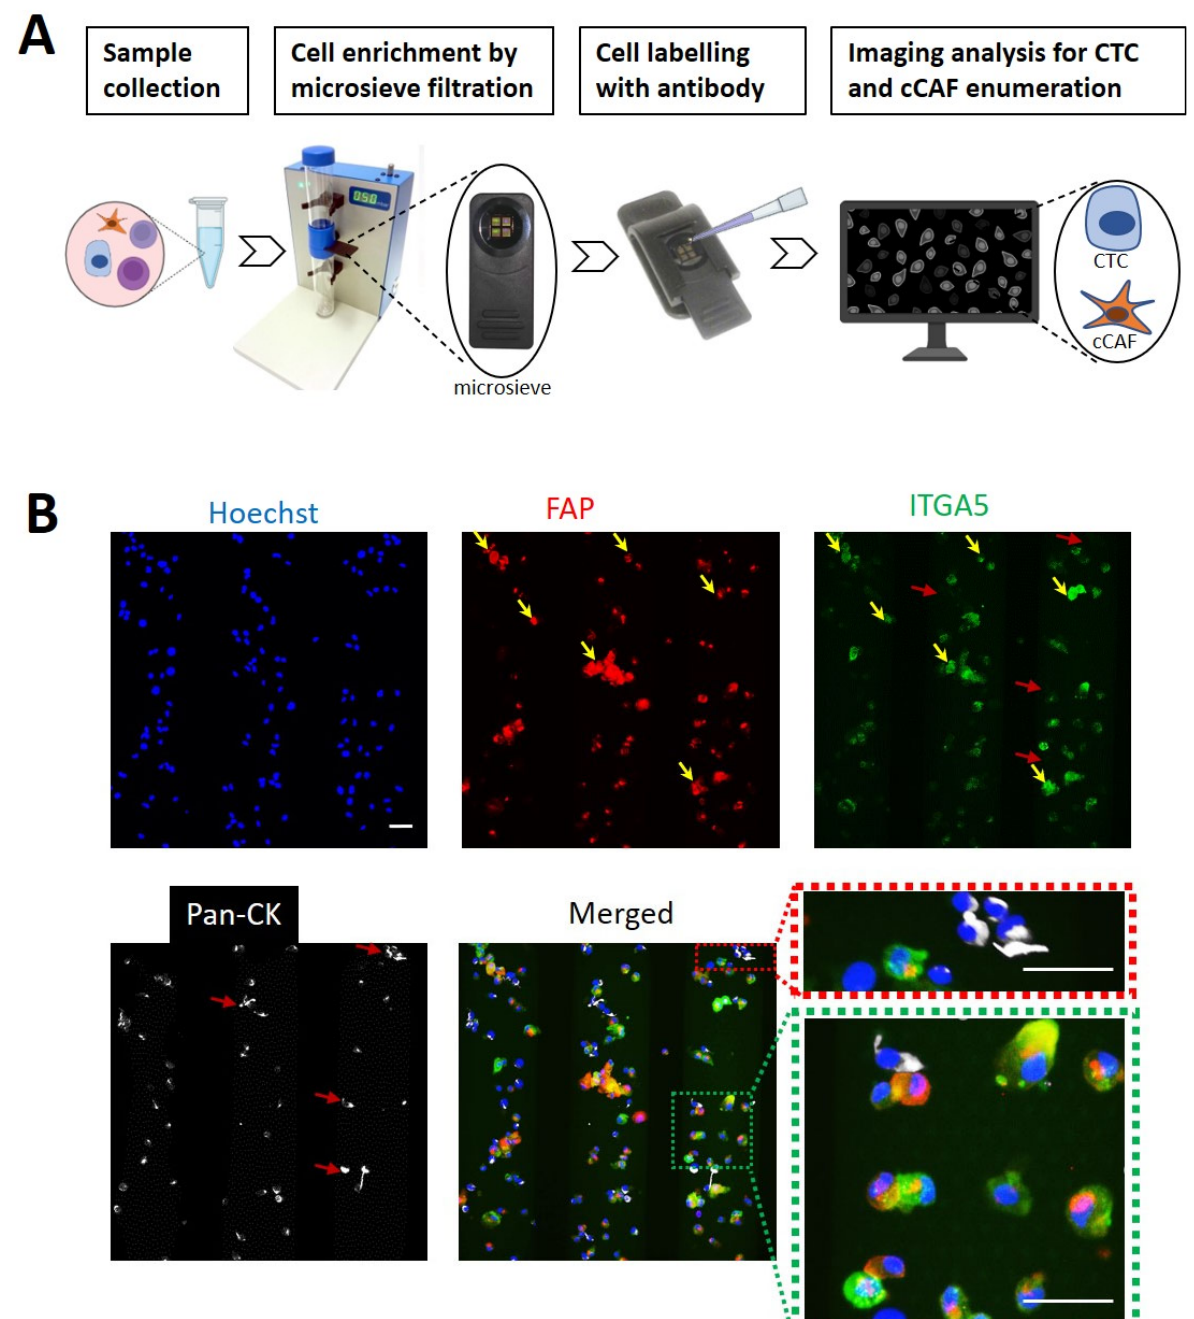
Figure 2. Microsieve filtration platform for circulating cell capture, enrichment and identification. ( A ) Schematic illustration of the workflow for cCAF and CTC capture using the microsieve filtration platform. ( B ) In vitro activated HMFs mixed with tumor cells for selected target staining. Yellow arrows indicate FAP (red) and ITGA5 (green) costaining on HMF, while the white signal indicates pan-CK specifically on MDA-MB-231 cells without any costaining on HMFs (red arrows). Scale bar, 40 μ m.